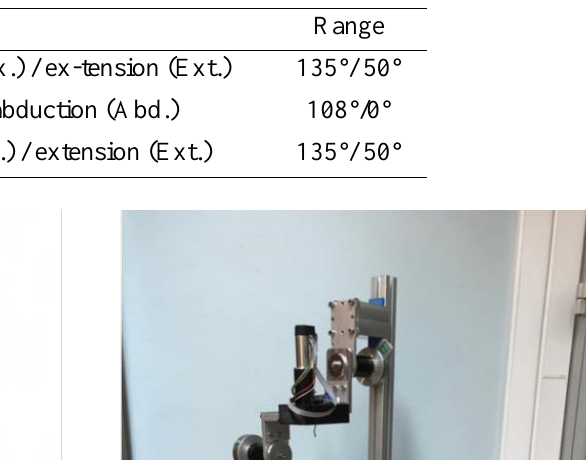
Table 2. Movement